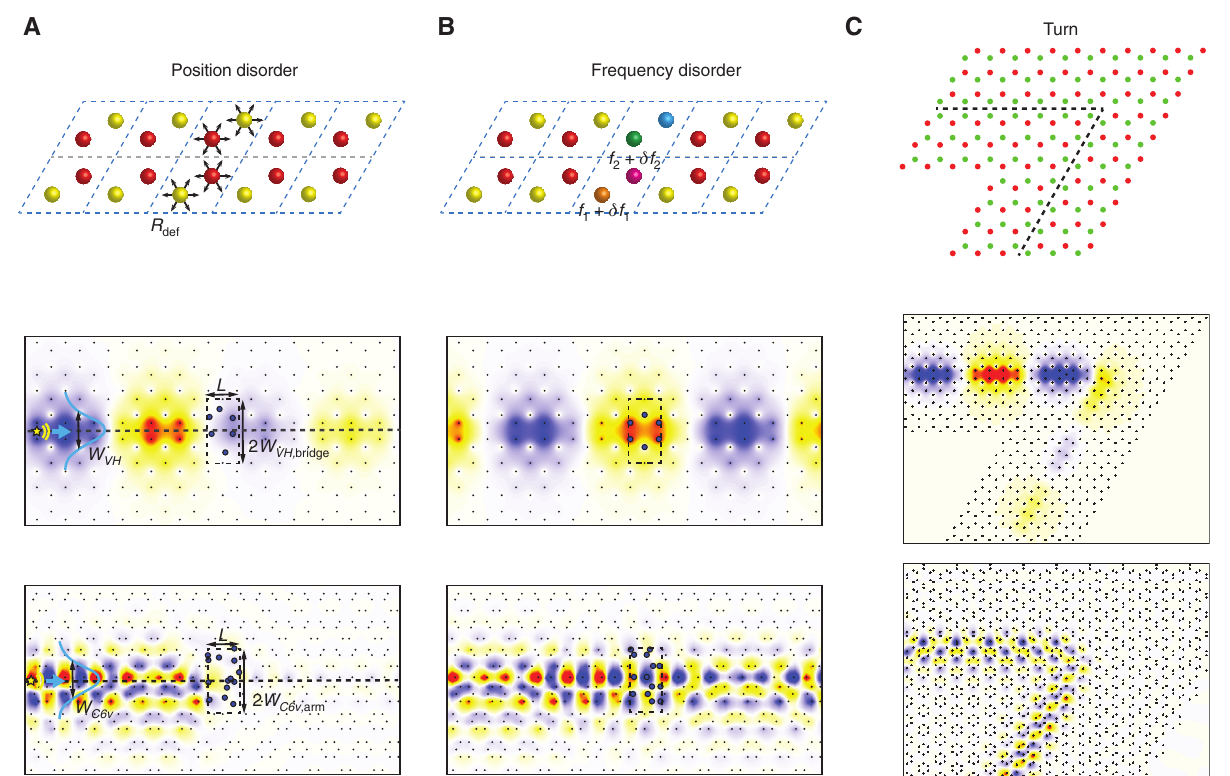
Figure 3: Different types of disorders and obstacles studied in this work. (A) Position and (B) frequency disorder (top panels) are introduced by displacing the resonators or changing their resonance frequency. The disorders are contained in a box of size 2 W × L along the interface, where W is the transverse mode width and L is the varying length of the box. Each resonator within this box is affected by a random disorder in the range [0, R ] for position and [− δ f , δ f ] for frequency disorders. def (C) Another type of obstacle is a sharp turn (top panel) and corresponding electric field distributions for VH metamaterial TI with bridge interface (middle panel) and C6 metamaterial TI with zigzag interface (bottom panel), respectively. The electric field color maps in (A) and = [0, 0.2 W ], δ f = [− BW , BW ], for position and frequency (B) are generated for a box length L = W and disorder strengths in the range of R def disorders, respectively ( BW is the bandwidth of the transmission band for each